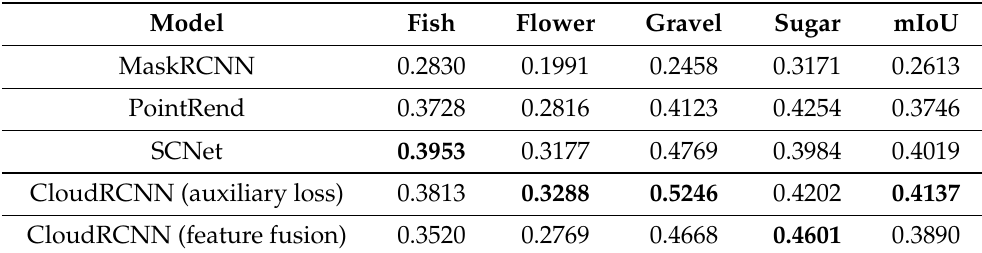
Table 2. Comparative results of five